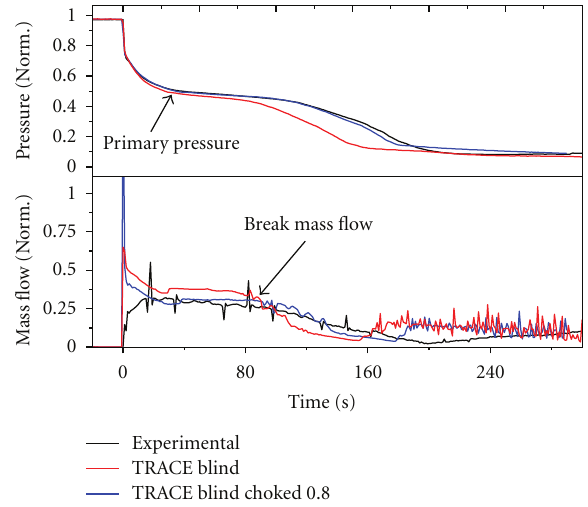
Figure 13: Accumulator injection during Test 1 with the new nodal- ization of the Acc’s lines.